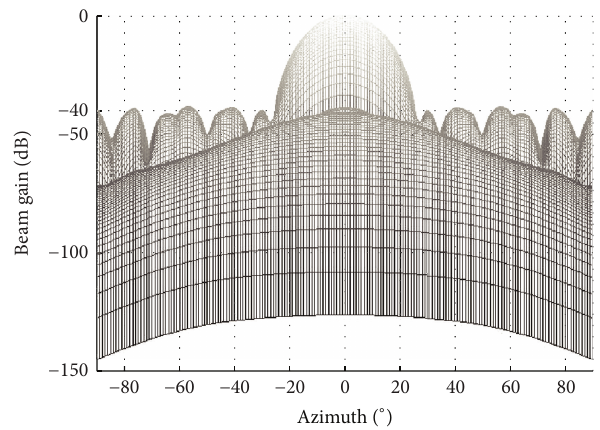
Figure 7: Beam pattern projection in the elevation direction.